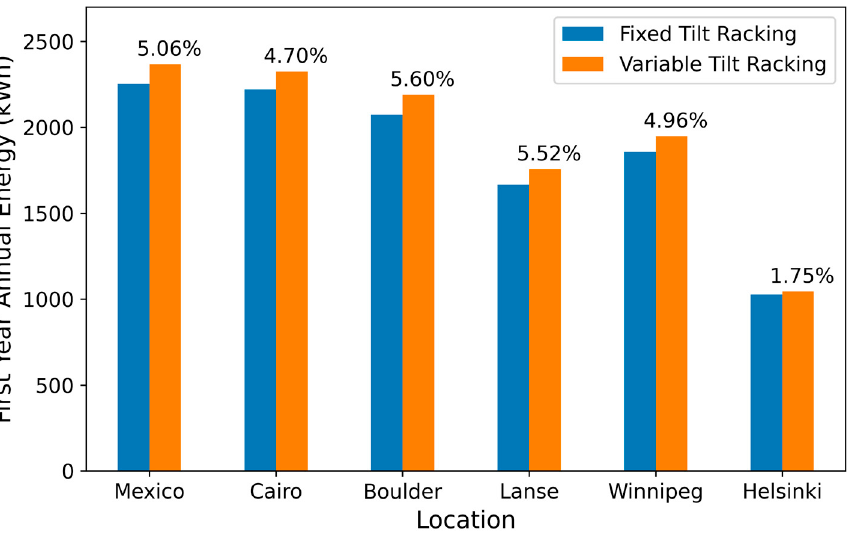
Figure 11. Comparison of the energy generated during the first year of operation by the fixed-tilt racking to the energy generated by the variable tilt racking for different locations in the northern hemisphere. The percentages on top of the bar plot represent the energy gain by using the variable tilt racking instead of the fixed-tilt racking.